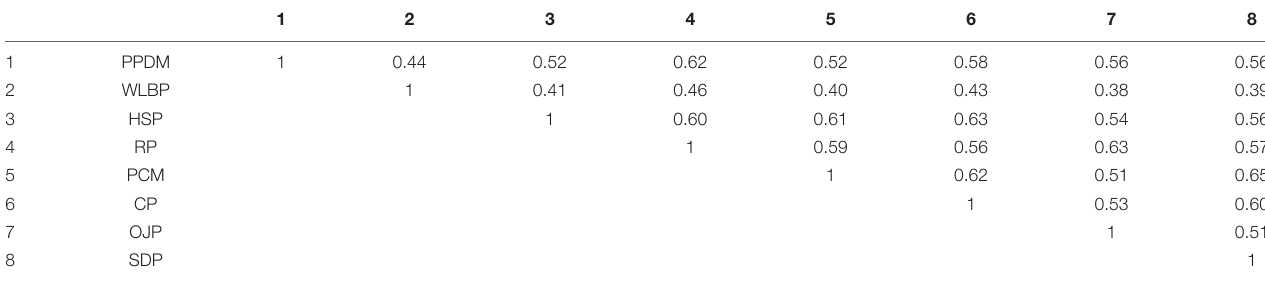
TABLE 3 | Inter-factor correlations (Study 2).